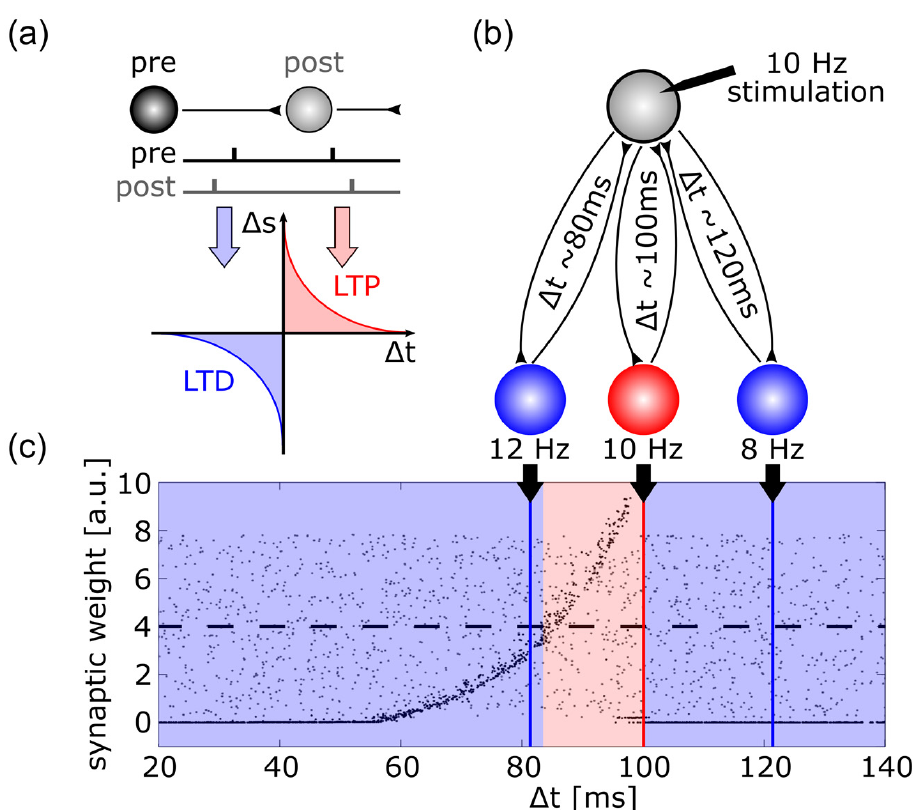
Figure 4. This figure illustrates the mechanism of spike-timing dependent plasticity (STDP) which might explain after-effects of transcranial brain stimulation. ( a ) Synaptic weights are increased if a post-synaptic potential follows a pre-synaptic spike, i.e., long-term potentiation (LTP) occurs, if, however, a post-synaptic potential occurs prior to a pre-synaptic spike, long-term depression (LTD) is the result; ( b ) schematic illustration of a network simulation: A driving neuron (gray) established a recurrent loop with each neuron of a hidden layer, the total synaptic delay (i.e., the sum of both delays of the loop) varied between 20 and 140 ms (only three such loops are shown here), the driving neuron was stimulated with a spike train of 10 Hz; ( c ) synaptic weights of the back projection as a function of the total synaptic delay of the recurrent loops: grey dots display synaptic weights at the start of the simulation ranging from 0 to 8, black dots represent synaptic weights after the end of simulation. External stimulation of the driving neuron at 10 Hz resulted in synaptic weights above the initial average of 4 (dashed line) for recurrent loops with a total delay between 82 and 100 ms, indicating LTP (region shaded in red). For all other delays, synaptic weights were reduced, indicating LTD (region shaded in blue).